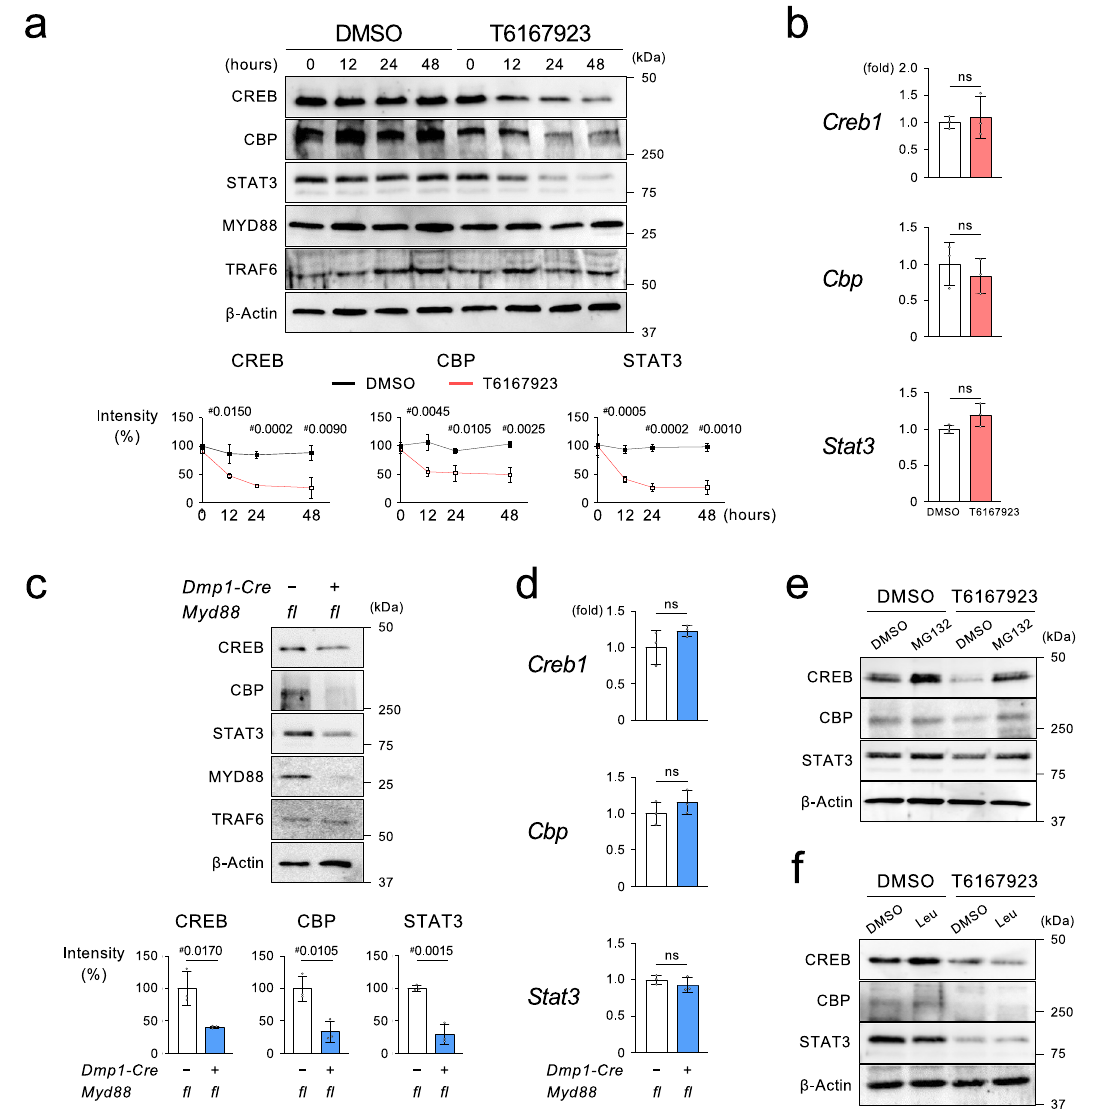
Fig. 6 | The MYD88 pathway regulates CREB, CBP, and STAT3 protein stability in the osteocyte-enriched cell population. a Western blotting of CREB, CBP, and STAT3 proteins in Ocy isolated from wild-type ( Myd88 +l+ ) male mice. Ocy was treatedwithT6167923orvehicle(DMSO)every24h.Graphsshowtheintensitiesof the protein bands relative to those of DMSO-treated Ocy at 0h (%). Graphs were created from the data of three independent experiments ( n =3). Normalized by β -Actin. b qPCRanalysisof Creb1 , Cbp ,and Stat3 inmale Myd88 +l+ Ocytreatedwithor Representativedatafromthreeindependentexperimentswithsimilarresults,each with three replicates ( n =3). c Western blotting of the indicated proteins in Ocy isolated from Dmp1-Cre ; Myd88 fl / fl and Myd88 fl / fl male mice. Graphs show the inten- sities of the protein bands from Dmp1-Cre ; Myd88 fl / fl mice relative to those from